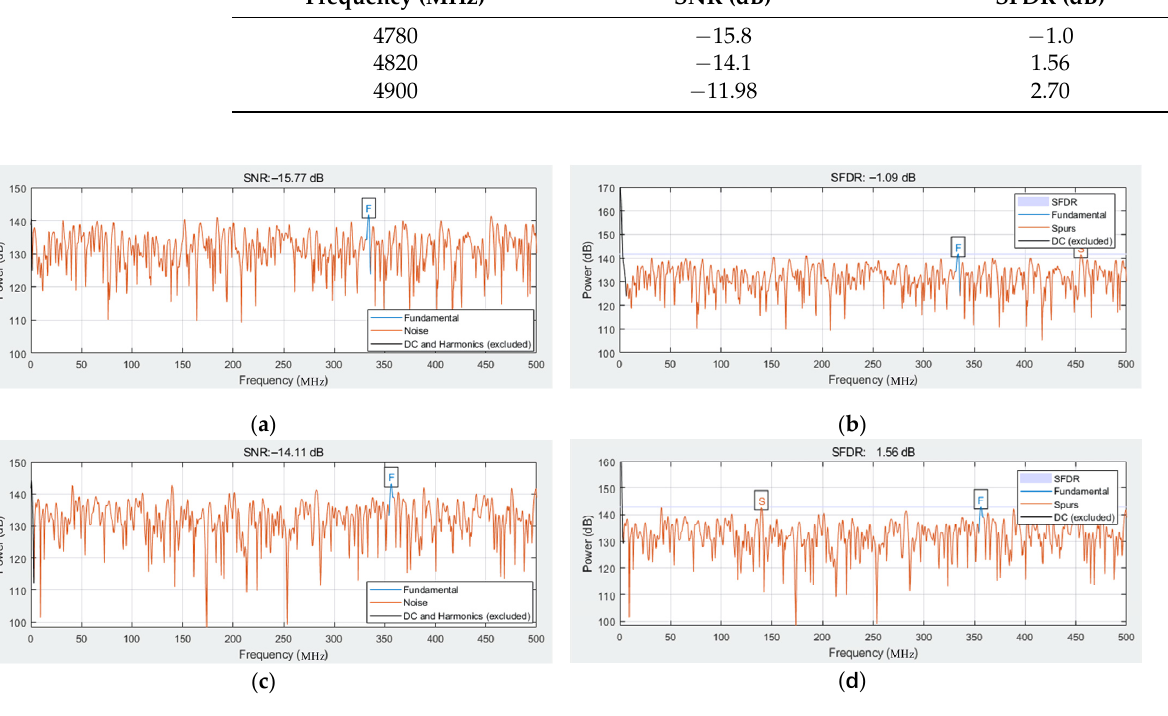
( f ) Figure 10. Extracted SNR and SFDR parameters: ( a ) extracted SNR when the frequency of the input signal is 4780 MHz; ( b ) extracted SNR when the frequency of the input signal is 4780 MHz; ( c ) ex- tracted SNR when the frequency of the input signal is 4820 MHz; ( d ) extracted SNR when the fre- quency of the input signal is 4820 MHz; ( e ) extracted SNR when the frequency of the input signal is 4900 MHz; and ( f ) extracted SNR when the frequency of the input signal is 4900 MHz.